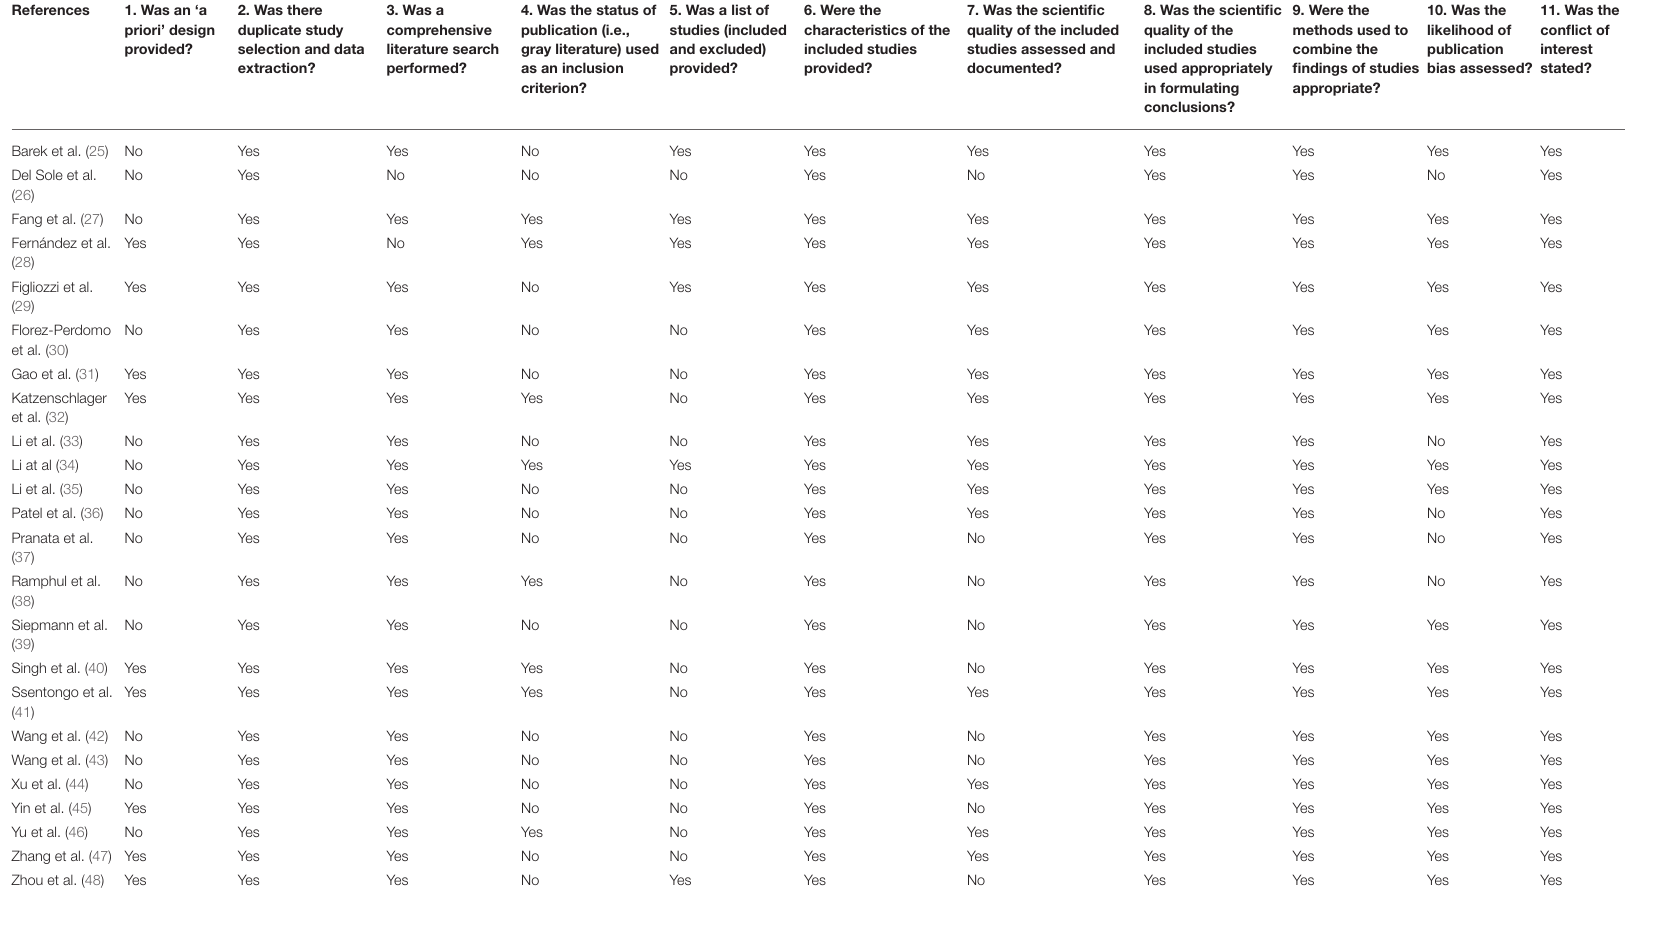
TABLE 6 | Quality appraisal of included systematic